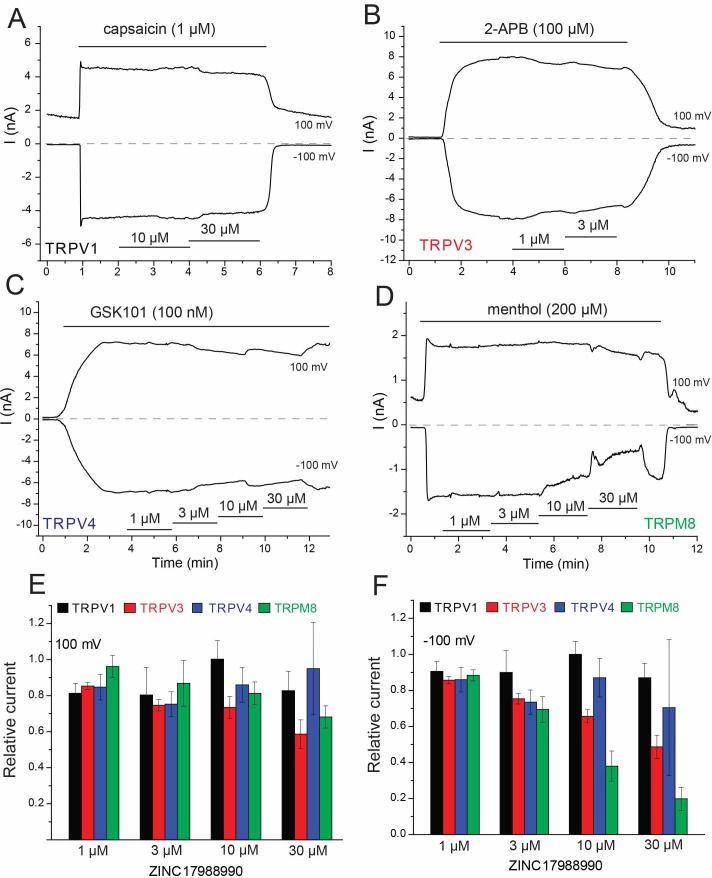
Effect of ZINC17988990 on other TRP channels.HEK293 cells were transfected with the mouse TRPV1, mouse TRPV3, the rat TRPV4 and the rat TRPM8 clones. Whole cell patch clamp experiments were performed as described in the methods section. (A–D) Representative traces for (A) TRPV1, (B) TRPV3, (C) TRPV4 and (D) TRPM8. The applications of the various channel agonists are shown with the horizontal lines above the current traces, the application of the different concentrations of ZINC17988990 are indicated by horizontal lines at the bottom. (E–F) Summary of the data at (E) 100 mV and (F) −100 mV. Current levels after two minutes of applying the various concentrations of the compounds were divided by agonist-induced current levels before the application of the drugs. Data show mean ± SEM, n = 3–4 for TRPV1, n = 3–6 for TRPV3, n = 4–6 for TRPV4 and n = 5–7 for TRPM8.